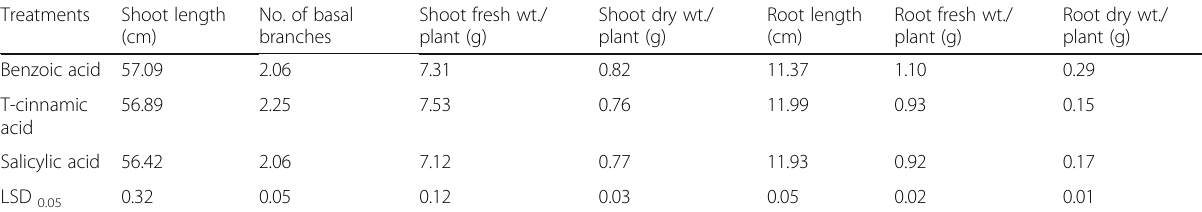
Table 5 Effect of phenolic acid treatments on growth parameters of flax plants grown under sandy soil conditions (data are means of two seasons) Treatments